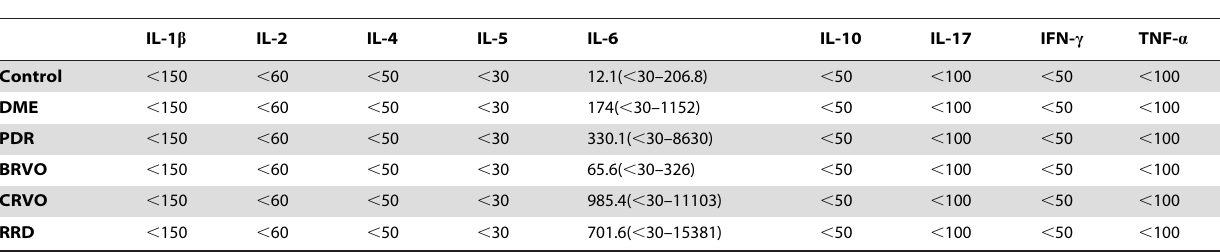
Table 2. Concentrations of cytokines in the vitreous